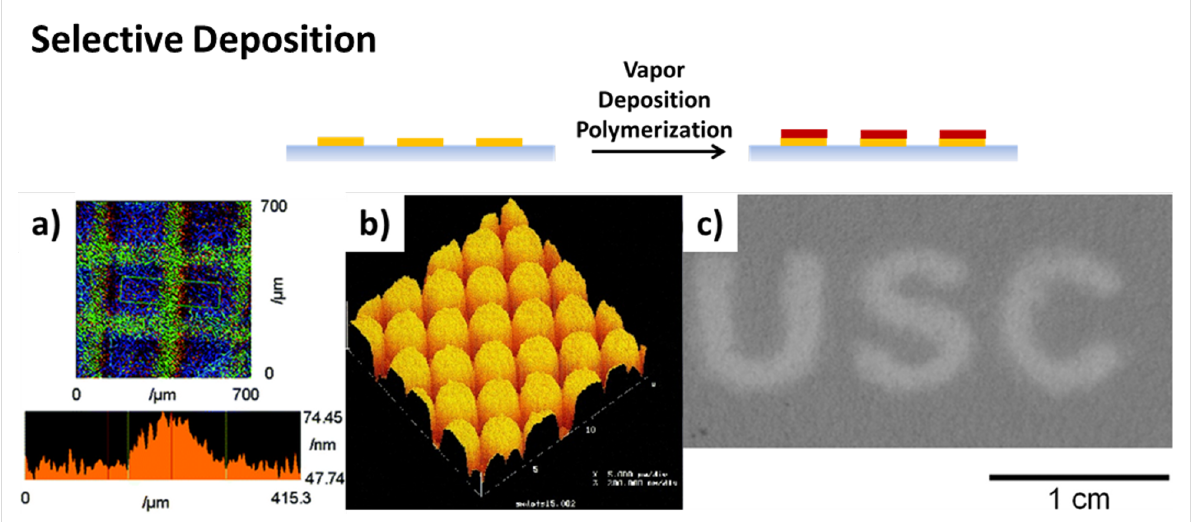
Figure 2: Formation of patterned polymer coatings by selective deposition strategies: a) spatially selective in situ activation of the surface-immobi- lized initiator in photoinduced vapor-phase-assisted surface polymerization of poly(methyl methacrylate), b) selective deposition of PPX-n on a hexa- decanethiol pattern (spot diameter 1.5 µm) on a silver surface, c) selective deposition of poly(4-vinyl pyridine- co -divinyl benzene) on copper-free regions (dark area) of chromatography paper. Permissions: (a) was reproduced with permission from [16], copyright 2006 The Royal Society of Chemistry, (b) was reprinted with permission from [18], copyright 2000 American Chemical Society, and (c) was reprinted with permission from [19], copyright 2015, American Vacuum